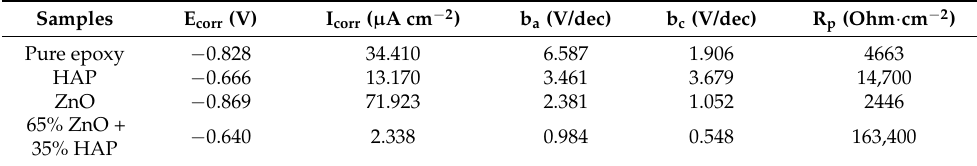
Figure 14. Tafel curves of different mild steel electrodes. Table 7. Dynamic polarization curve parameters of different mild steel electrodes.